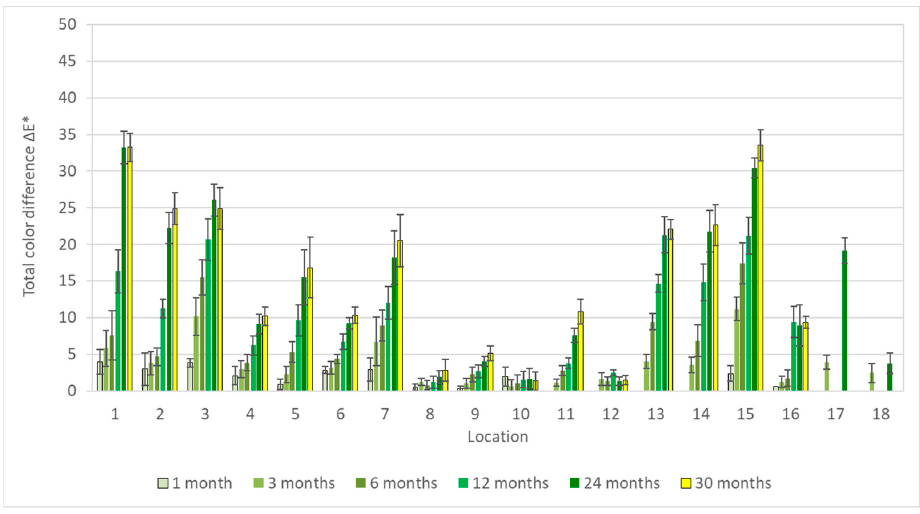
Figure 1. Total color differences of silver corrosion coupons after 1–30 months of exposure.